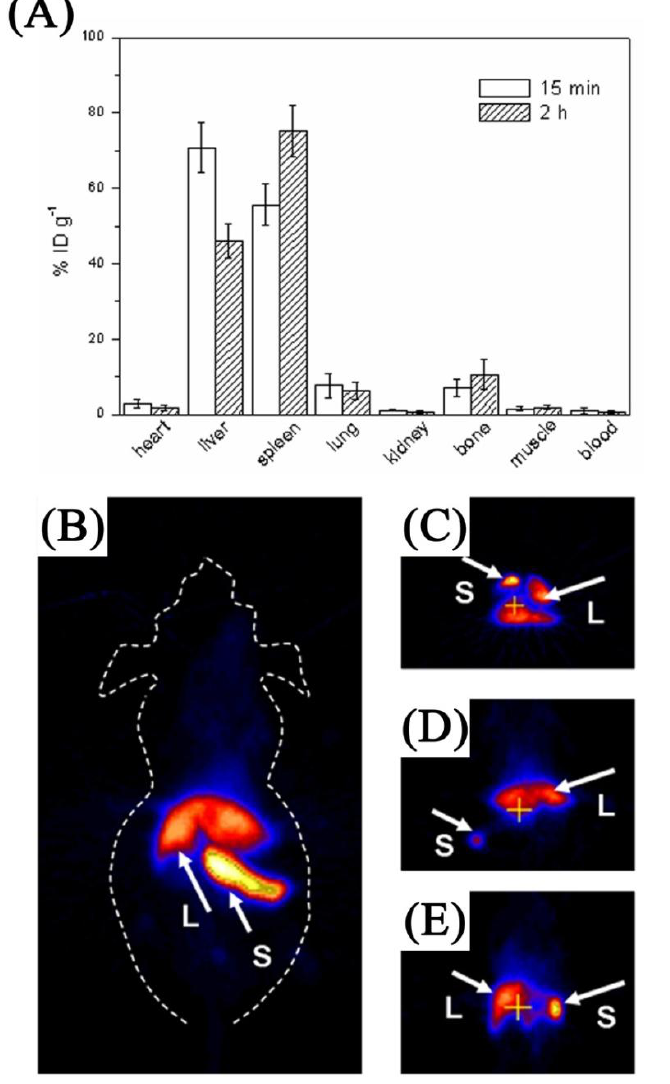
19. Application of Fluorine labeled UCNPs as multimodal probes ( A ) Biodistribution of at different post-injection times; ( B ) Whole-body two-dimensional projection, and ( C ) transversal, ( D ) coronal, and ( E ) sagittal images of the liver (L)